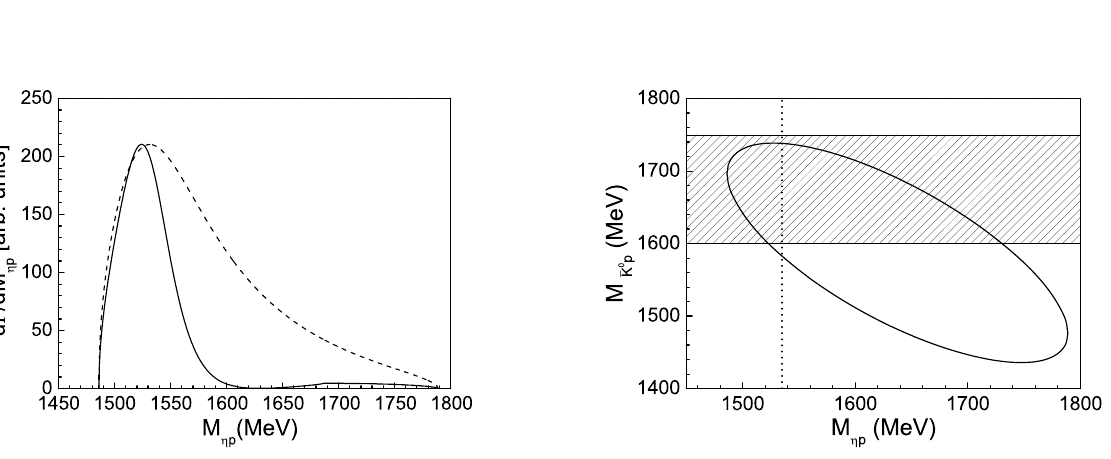
Figure 5. Invariant η p mass distribution for the Λ + decay. The solid and dashed curves represent the results obtained in Model I and II, respectively.